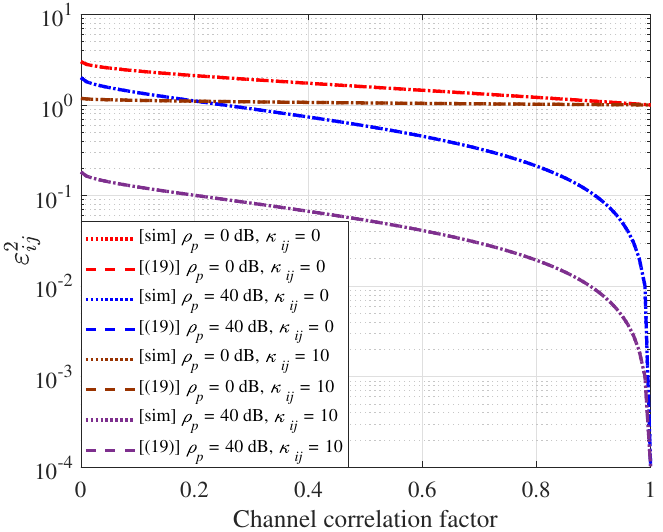
Figure 4. Comparison of the analyzed error variance in (19) and simulated values with M = 64. The channel correlation factor along the x-axis corresponds to ( c ij ) n i